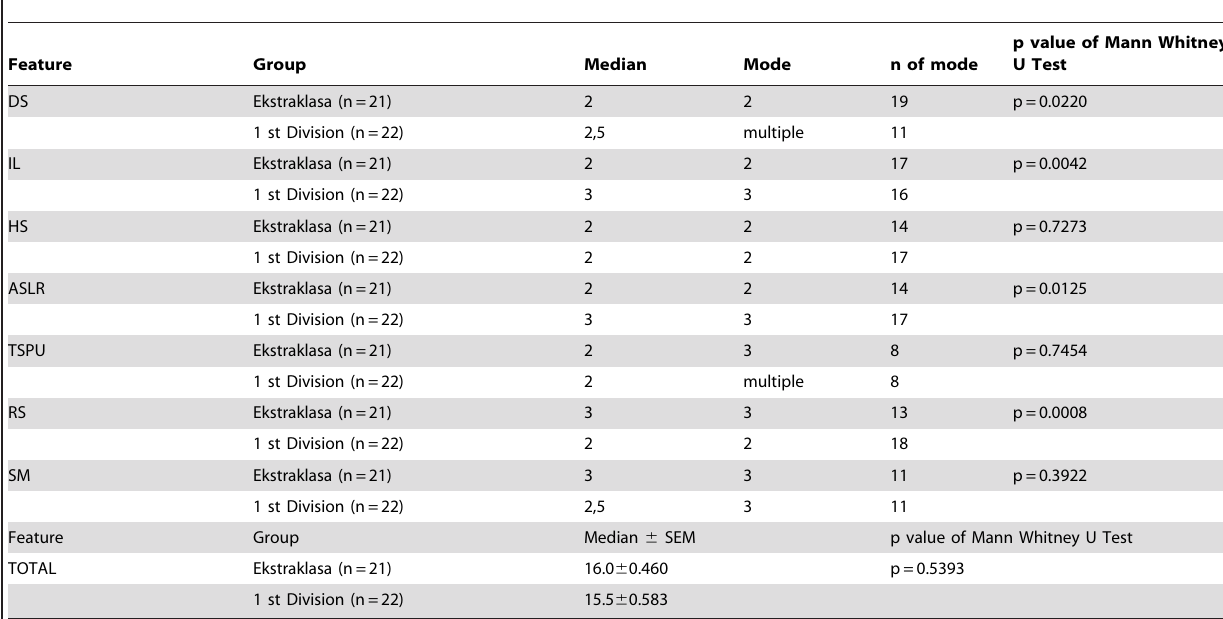
Table 3. Analysis of differences in FMS TM test results among players with different soccer skill levels.